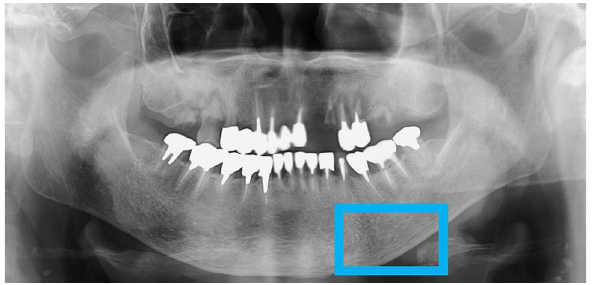
Figure 2. Dental panoramic radiographs before deep learning analysis, showing cropped ROI.